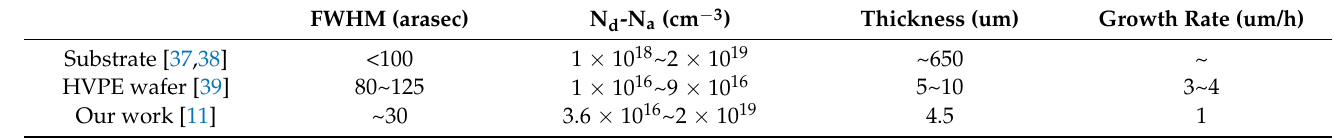
Table 1. Parameters of Ga 2 O 3 substrates and epitaxial wafers. FWHM